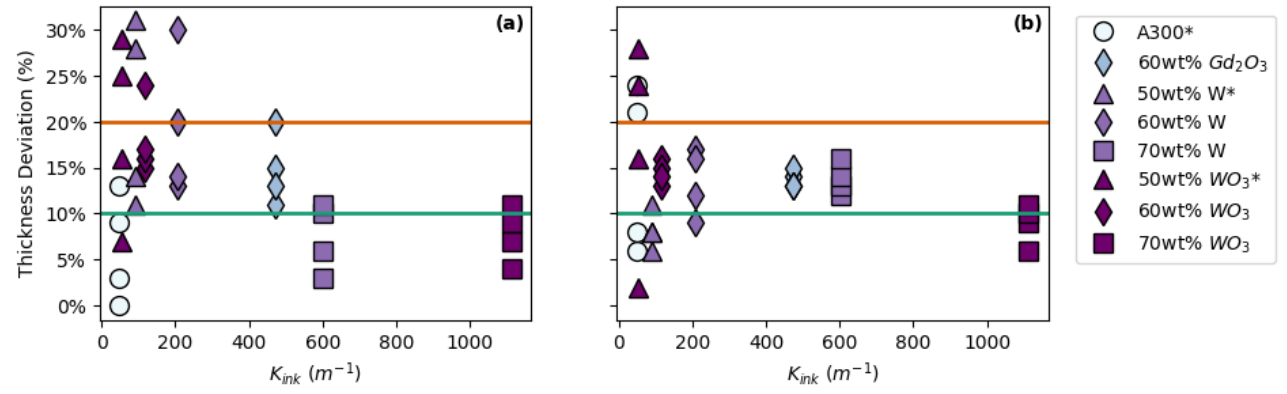
Figure 8. Relating print thickness deviation to ink rheology (K ink ) for: ( a ) FCT prints and ( b ) SC